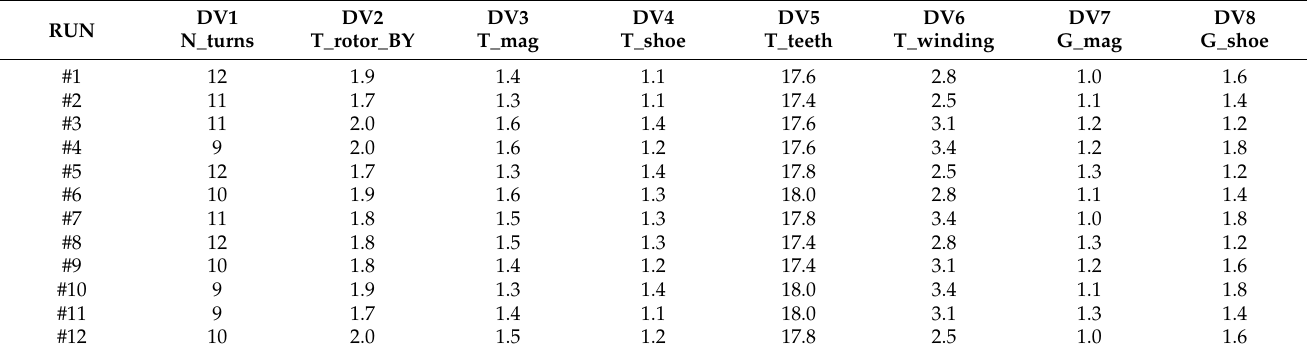
Table 4. DOE worksheet of DRAFPM